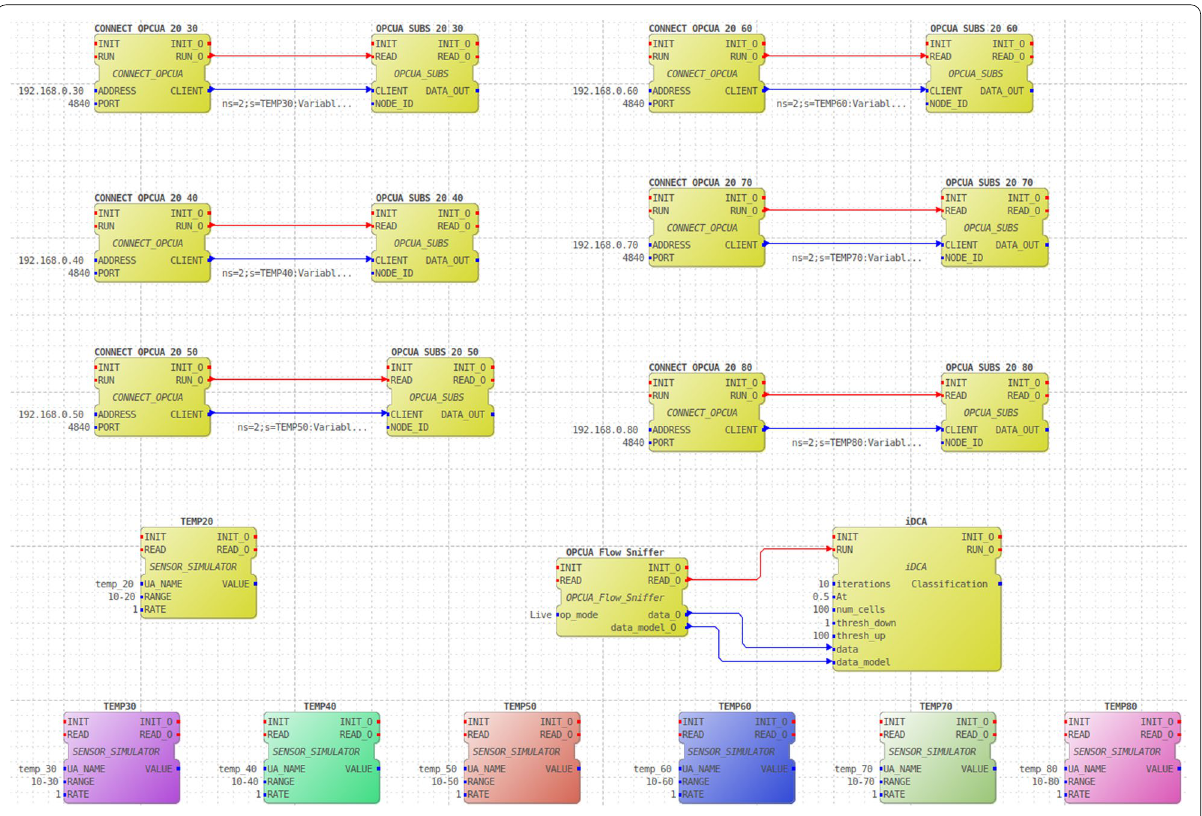
Fig. 6 Experimental setup—function block